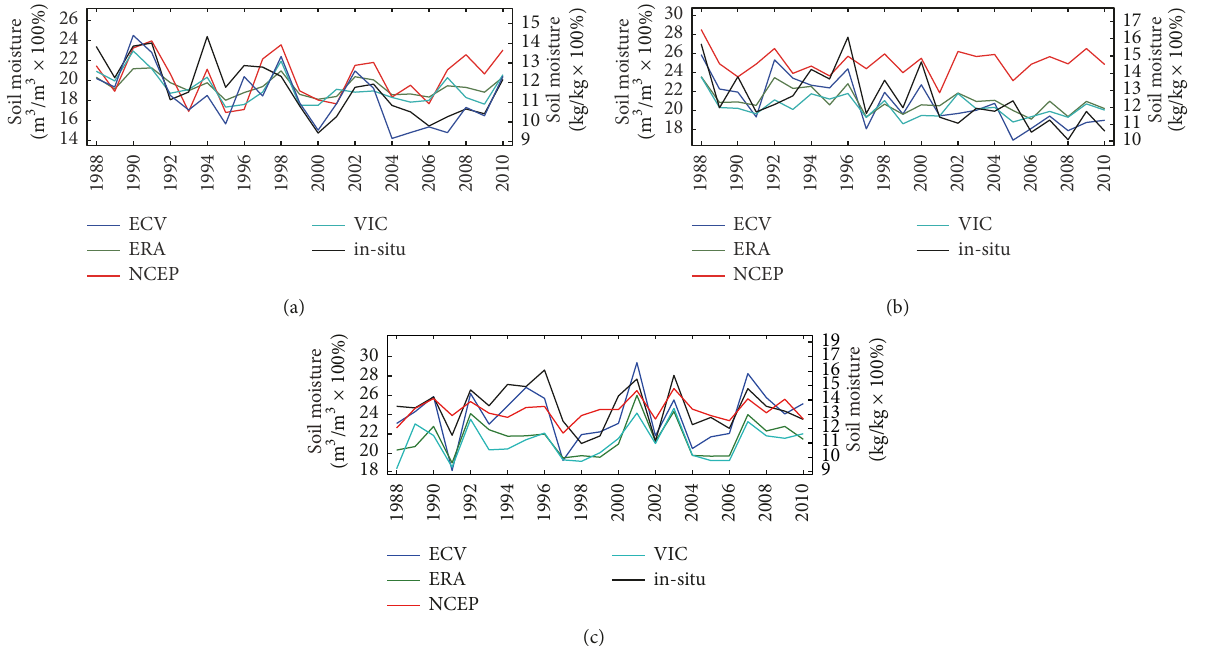
Figure 7: Interannual soil moisture variations in spring, summer, and autumn for the period of 1988–2010, which are spatially averaged in the selected study